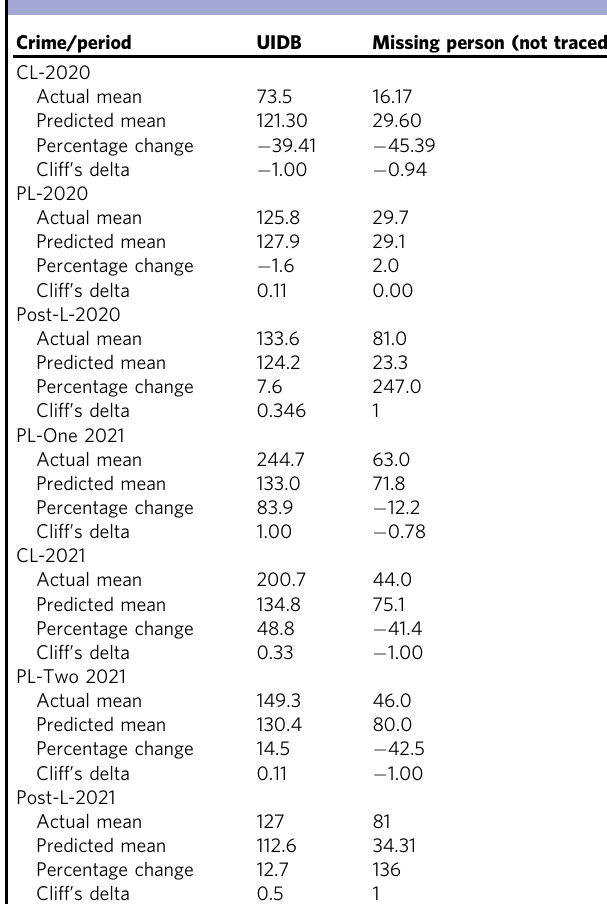
Table 6 Actual and predicted weekly counts of violent crimes during various phases of lockdowns in waves one and two in chennai in 2020 –